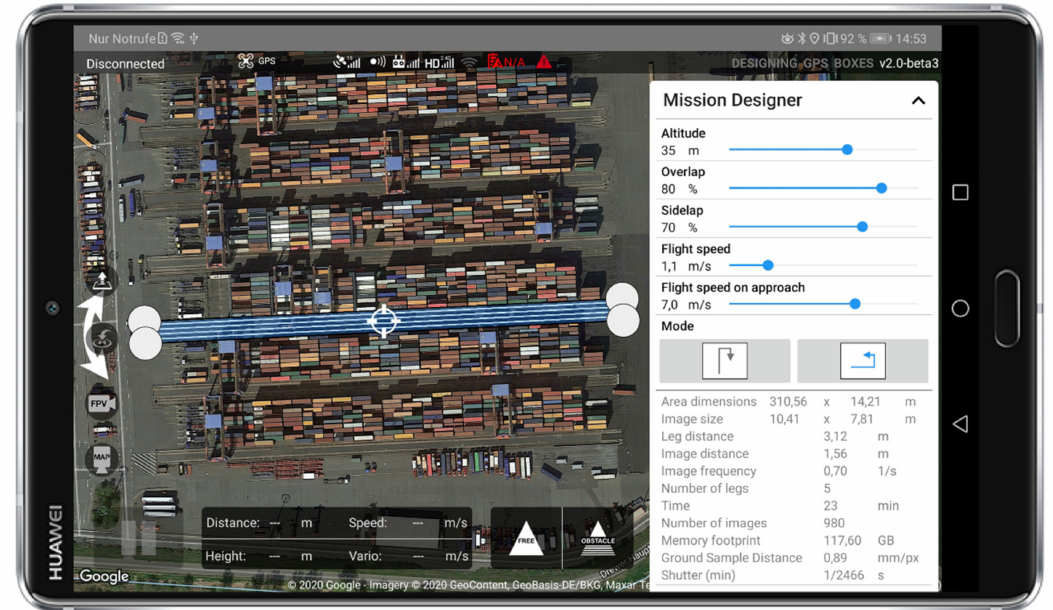
Figure 6. Mission Planning in the Inspekt GS